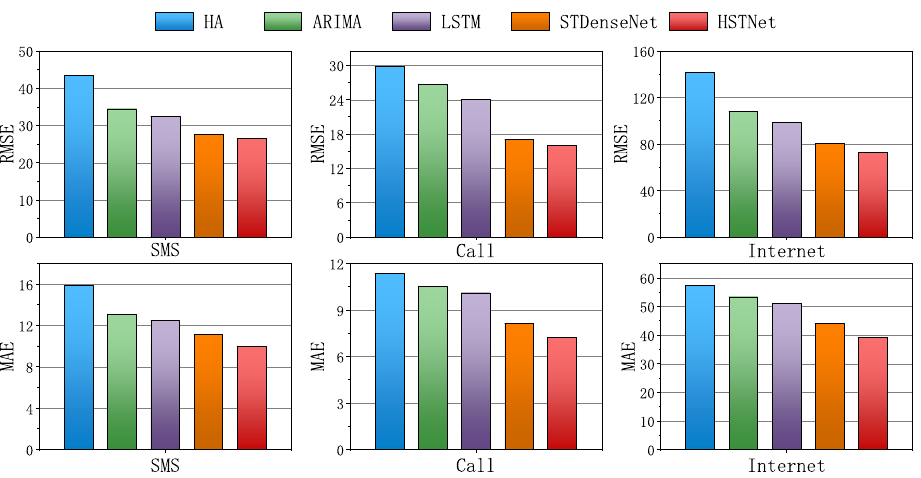
Figure 8. Comparison of prediction performance on the baseline and HSTNet. HA, historical average.